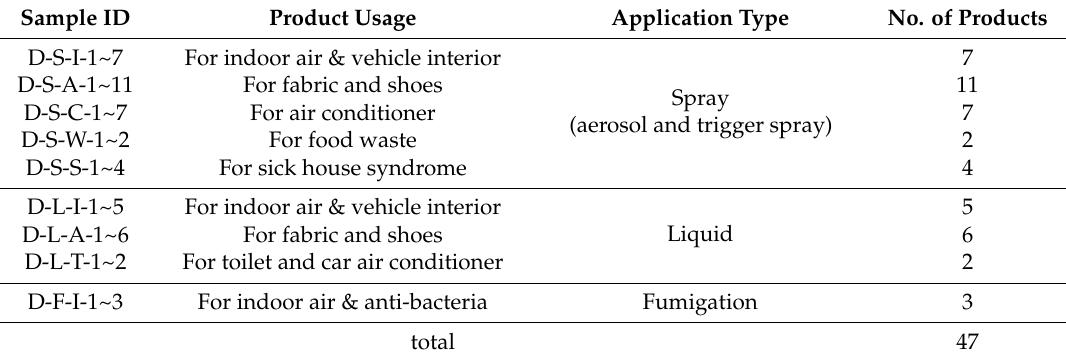
Table 1. List of deodorizing agents studied.